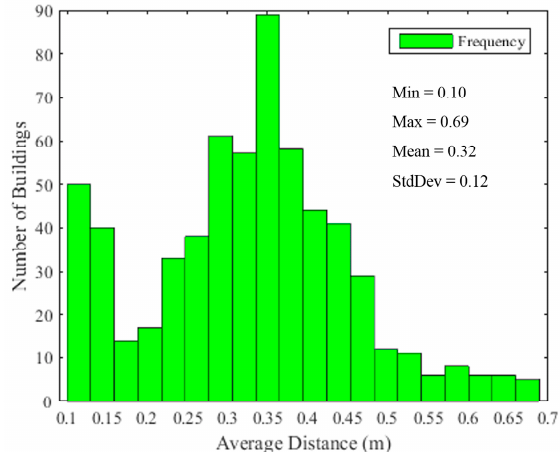
Figure 8. Statistical result of the performance.